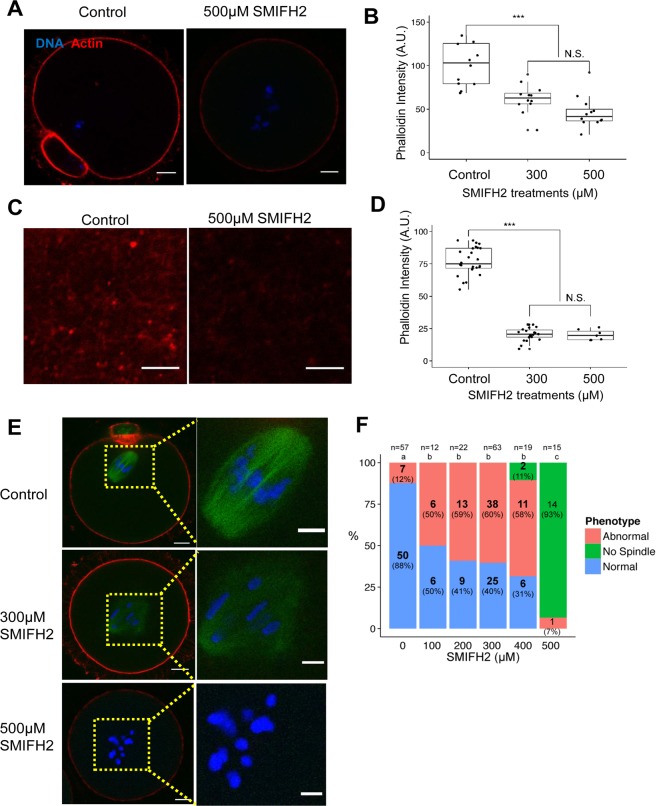
Treatment with SMIFH2 decreases the actin level in oocytes and impairs spindle formation.
A. Treatment with SMIFH2 decreases the cortical actin level in maturing mouse oocytes. Control (left) and oocytes treated with 500 μM of SMIFH2 were stained with phalloidin to visualize actin (red). Chromatin was stained with Hoechst 33342 (blue). Bar = 10 μm. B. Quantification of the cortical actin levels in SMIFH2-treated (300 and 500 μM) and control oocytes. Actin in the cortex regions excluding the cortical actin cap and polar body regions was quantified using ImageJ[42]. The box represents the interquartile range; the whiskers show 1.5x the interquartile range; line inside the box represents the median (control: n = 14; 300 μM: n = 12; 500 μM: n = 12). N.S.: not significant (p > 0.05); ***: significantly different from control oocytes (p < 0.001). C. Phalloidin-stained cytoplasmic actin mesh in oocytes. Untreated (control) oocytes and oocytes treated with 500 μM of SMIFH2 were stained with phalloidin to visualize actin (red). Bar = 3 μm. D. Quantification of the cytoplasmic actin stained with phalloidin in control (n = 27) and SMIFH2-treated (300 μM: n = 21; 500 μM: n = 7) cells. E. Abnormal spindle formation induced by SMIFH2 treatment. Spindles of control or SMIFH2-treated (300 and 500 μM) oocytes were visualized by immunostaining with anti-α-tubulin (green), and chromatin was stained with Hoechst 33342 (blue). No spindle structures are detected in oocytes treated with 500 μM of SMIFH2. Bar: 10 μm. F. Effect of various SMIFH2 concentrations on spindle formation and morphology. Oocytes were classified based on the spindle morphology. Normal: oocytes with normal spindle shape with proper chromatin alignment, similar to the spindle shape of the control cells in panel E; Abnormal: oocytes containing a spindle with improper chromatin alignment or irregular shape, similar to that of cells treated with 300 μM SMIFH2 in panel E; No spindle: oocytes with no detectable spindle structure, similar to that of cells treated with 500 μM SMIFH2. The ratio of each spindle type of oocytes to total oocytes was plotted. Significant differences (p < 0.05) between different treatments are indicated by a different superscript letter(a,b and c).